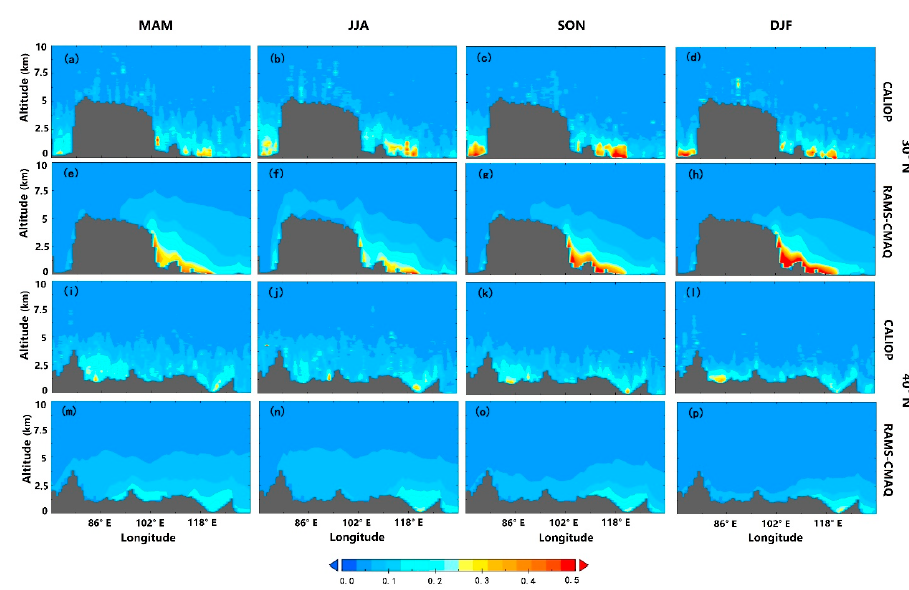
Figure 7. Cross sections of the seasonal mean AECs (unit: km − 1 ) along 30 ◦ N and 40 ◦ N latitude from CALIOP and RAMS-CMAQ.